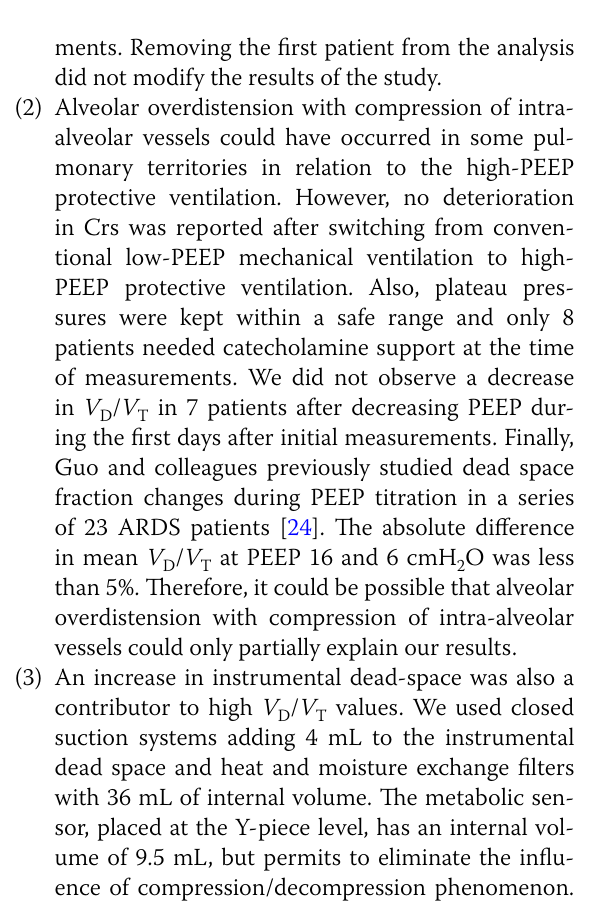
Table 2 Published reference values on V